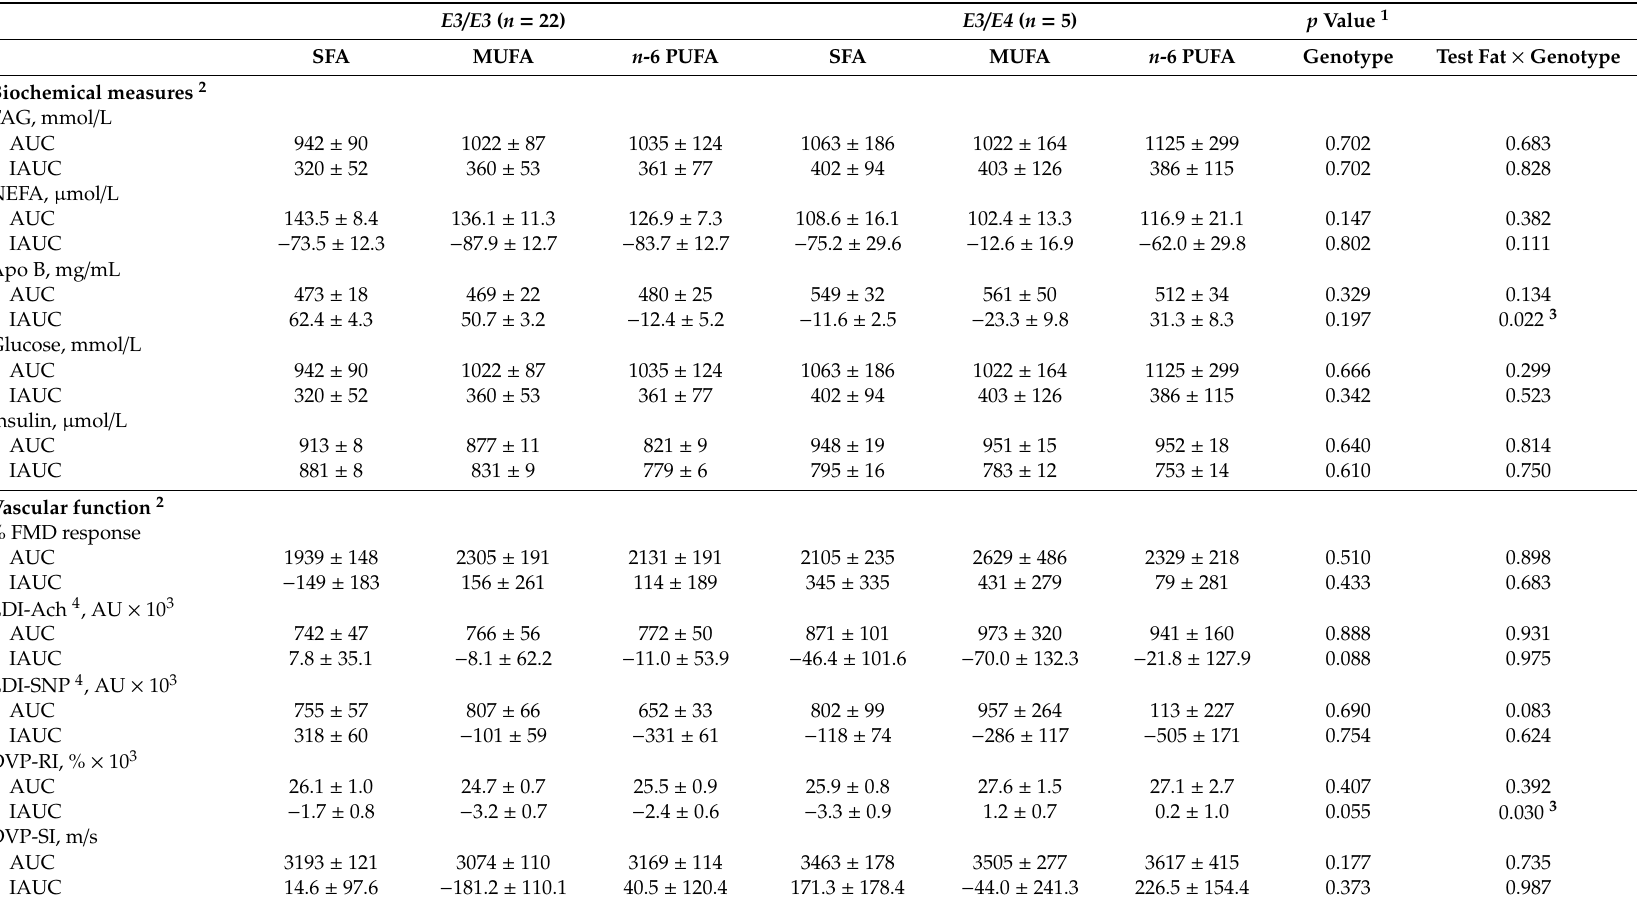
Table 3. Summary measures for the impact of the APOE genotype on postprandial cardiometabolic risk markers after sequential meals of varying fat composition (DIVAS-2